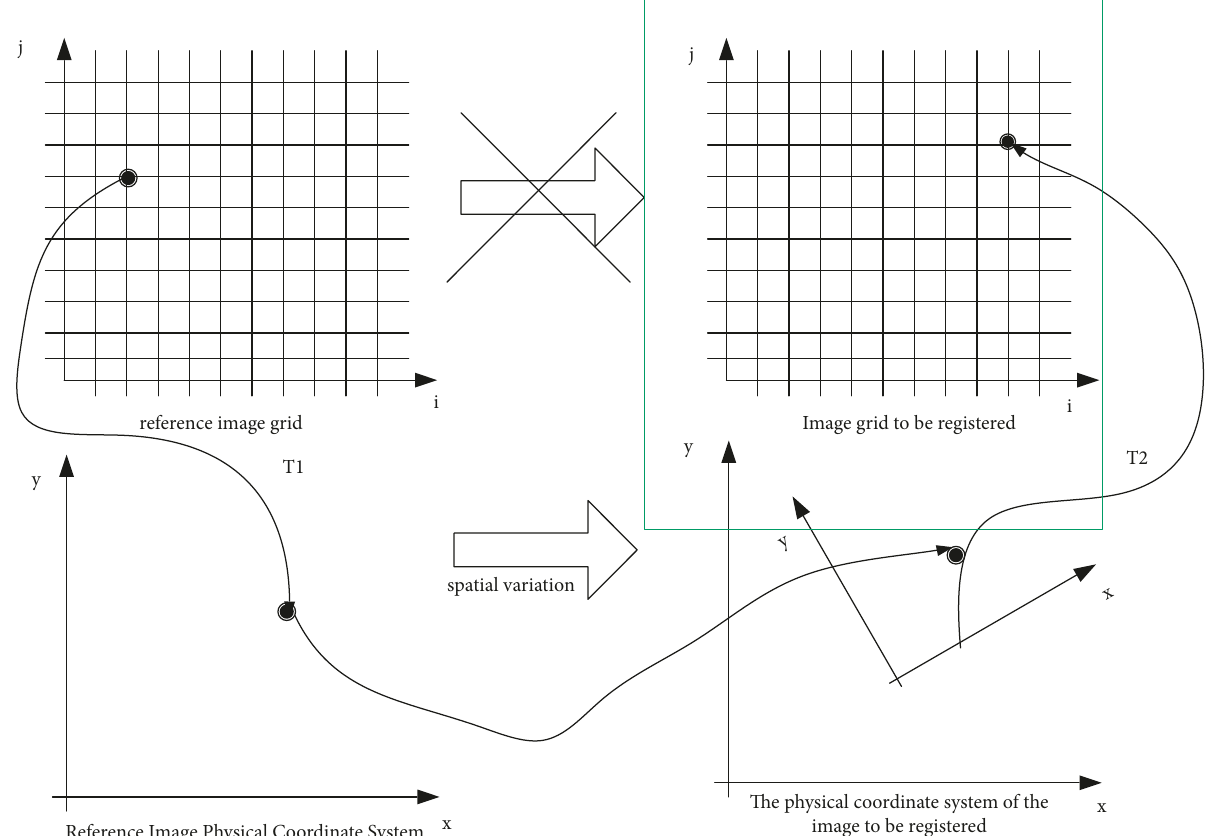
Figure 7: Spatial mapping relationship between points on the reference image and points on the image to be registered.